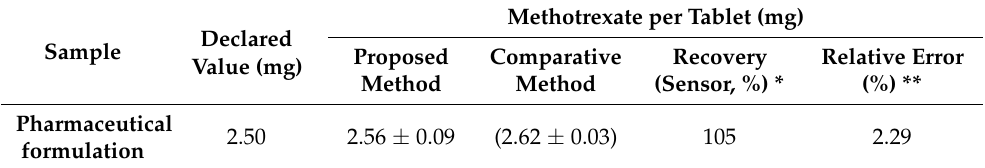
Table 3. Results obtained from the analysis of pharmaceutical formulation samples.